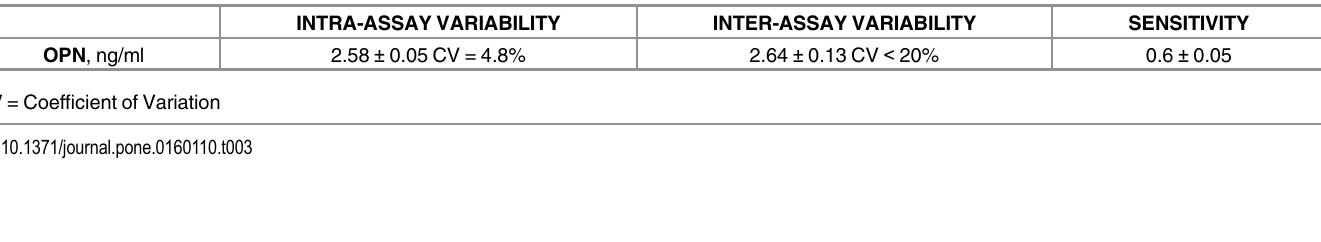
Table 3. Analytical performance of OPN